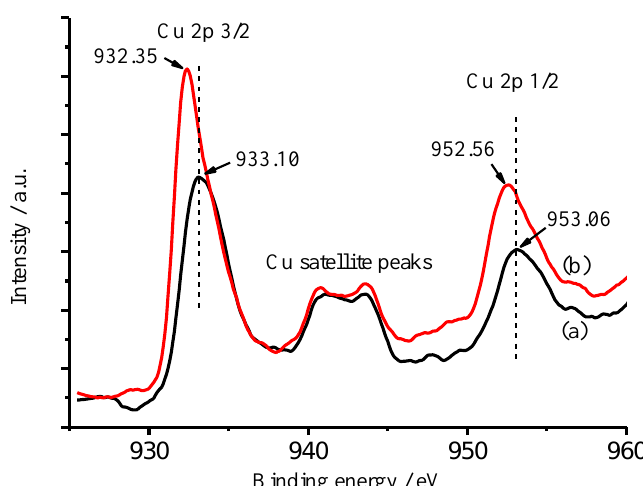
Figure 15. High-resolution XPS spectra of Cu component in the CuFe 2 O 4 sample before ( a ) and after ( b ) it was immersed in 100 mg/L NH 3 -N solution, respectively.